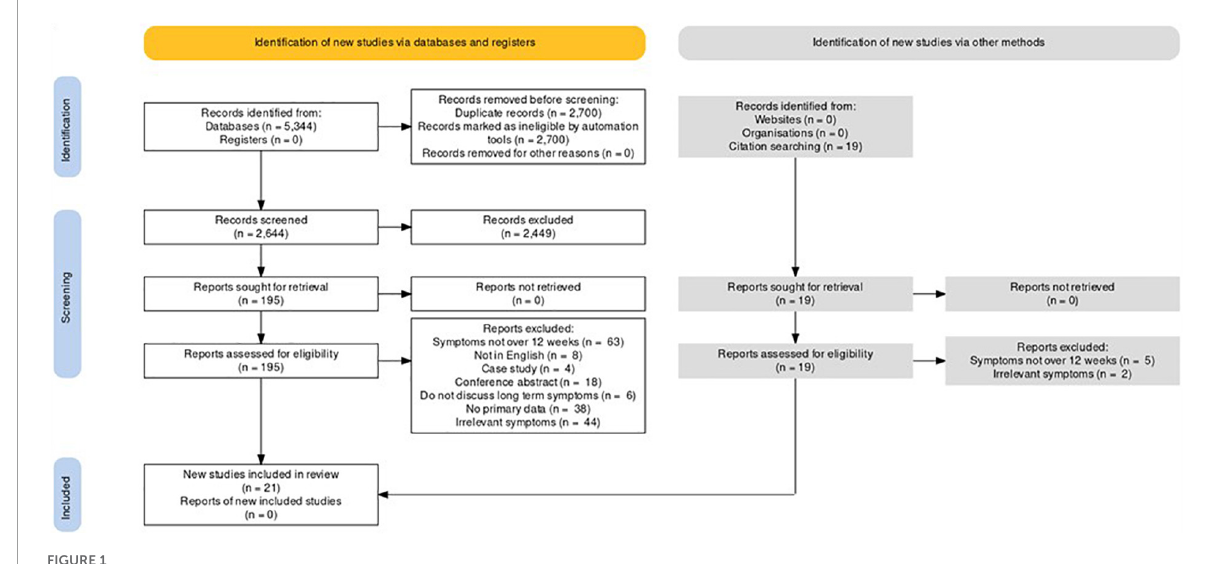
FIGURE1 PRISMA flowchart of included